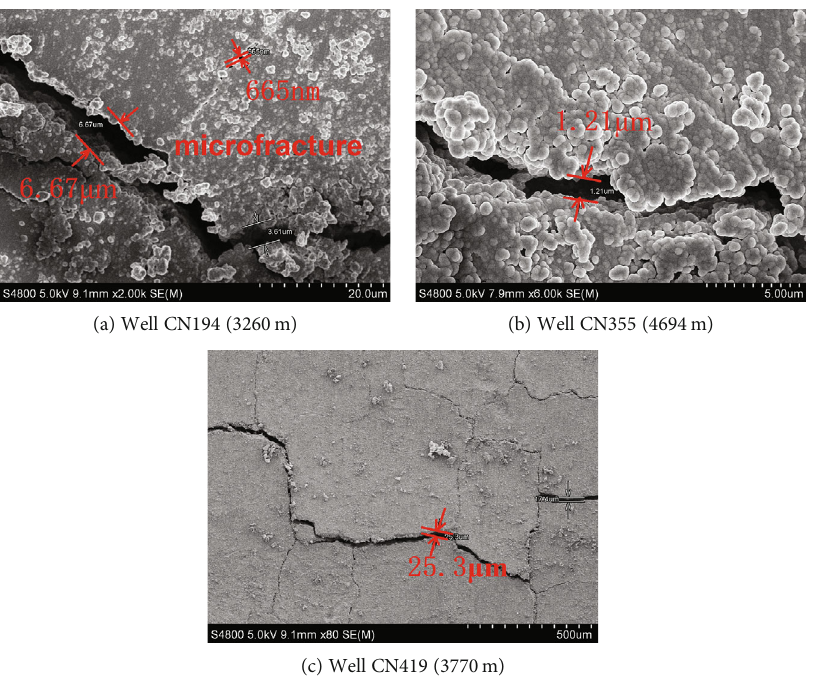
Figure 2: SEM images of rock samples of Wufeng